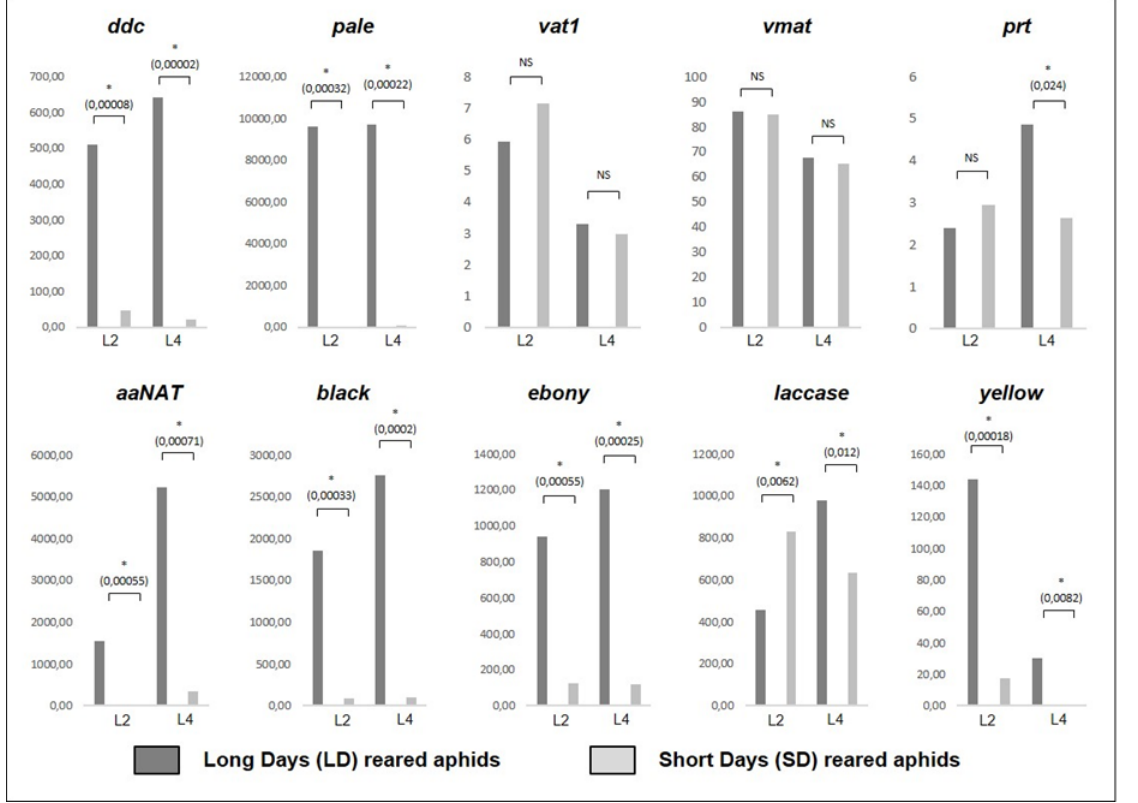
Figure 3 – Expression levels of dopamine pathway genes in L2 and L4 larvae heads of long day (LD) and short day-reared aphids. Based on a previous microarray analysis of the transcriptomic response in the heads of aphids when submitted to photoperiod shortening (Le Trionnaire et al., 2009), the same RNA samples were used for RNA- sequencing. The level of expression (expressed as RPKM) of dopamine pathway genes was extracted from this dataset and statistically analyzed using EdegR package to identify differentially expressed genes between the two photoperiod conditions (the p-value of the test is indicated between brackets). *: Significant, NS: